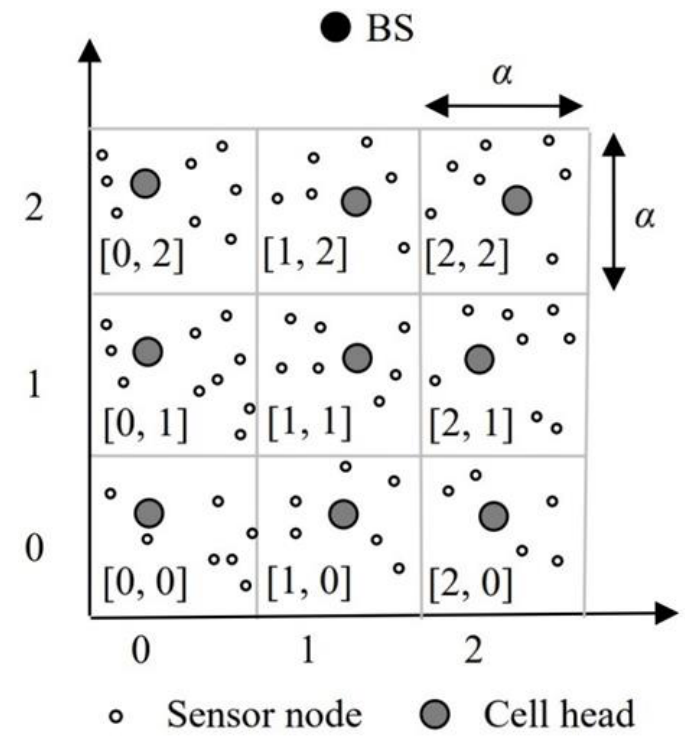
Figure 1. Grid Figure 1. Grid structure.